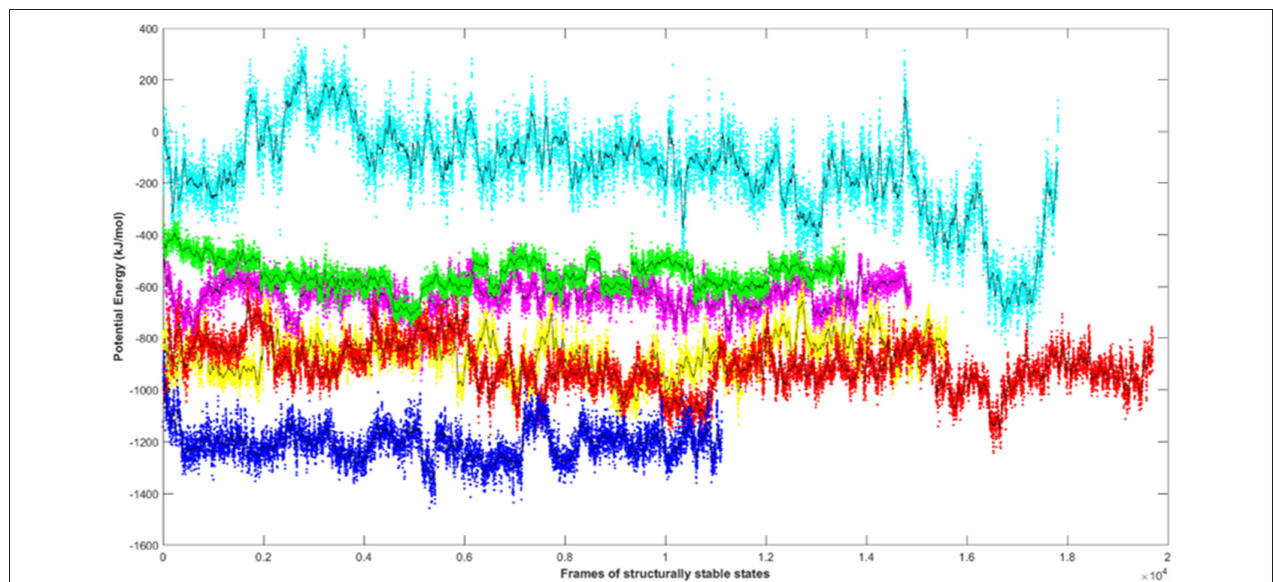
FIGURE 3 | Plot showing the potential energy profiles of the six AIM/LIR— Pf Atg8/ Hs LC3 complexes computed for the structurally stable conformations. The energies represented as line plots in different colors depicts Pf Sec62 QSYIDI (magenta), Pf Sec62 SMYKSI (cyan), Pf Sec62 ENYDCL (yellow), Pf Sec62 TSFEEL (red), Pf Atg3 NDWLLP (green) upon binding to Pf Atg8 and Hs Sec62 NDFEMI (blue) on interacting with Hs LC3. The line in black indicates the moving average calculated for the energies over 50 conformations.